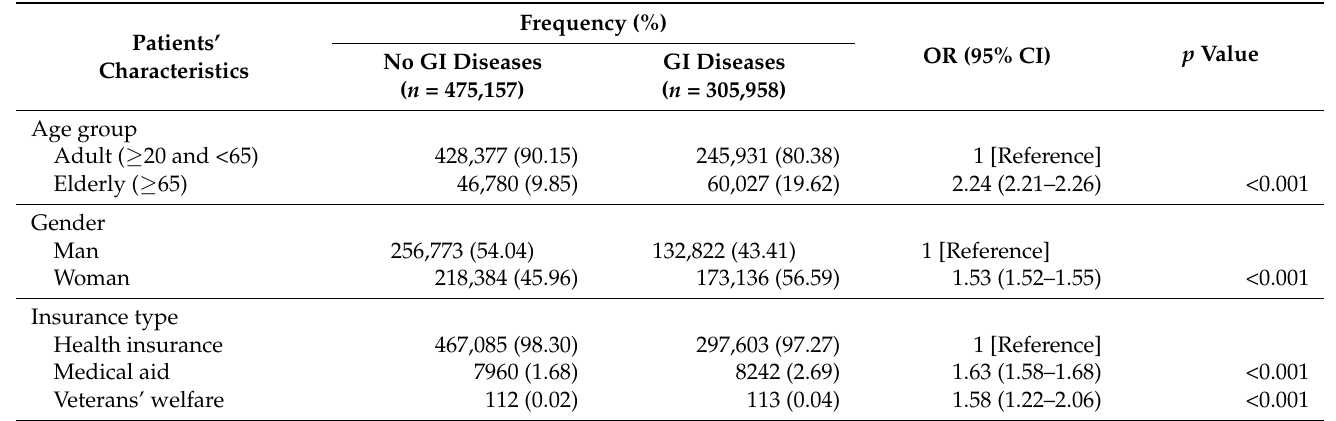
Table 1. Patient characteristics according to gastrointestinal diseases.